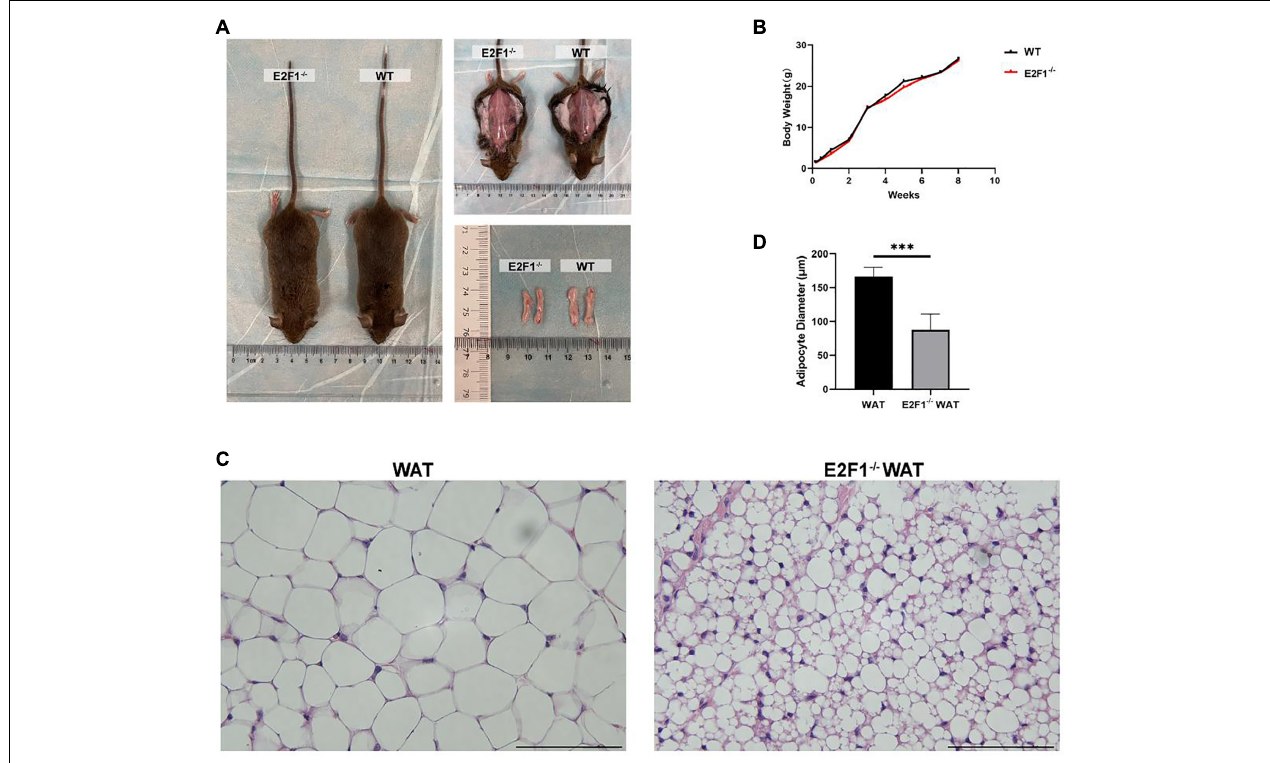
FIGURE 1 | Effects of E2F1 knockout on body weight and inguinal adipose tissue morphology in mice. (A) Gross view of mice, in situ subcutaneous WAT, and ex vivo dissected WAT in WT and E2F1 − / − group. (B) The bodyweight curve of the WT and E2F1 − / − mice ( n = 10) for 8 weeks. (C) Representative H&E staining images of WAT in WT and E2F1 − / − mice. Scale bar, 100 µ m. Magnification, 400 × . (D) Quantitative analysis of adipocyte diameter in WT and E2F1 − / − WAT. ∗∗∗ P <